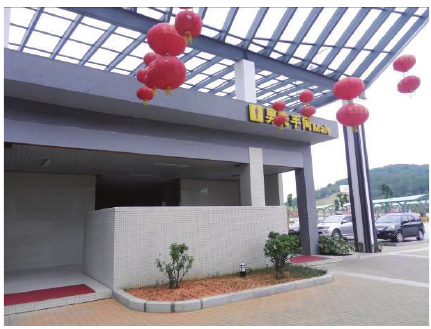
Figure 12: Glass roofs of the washing